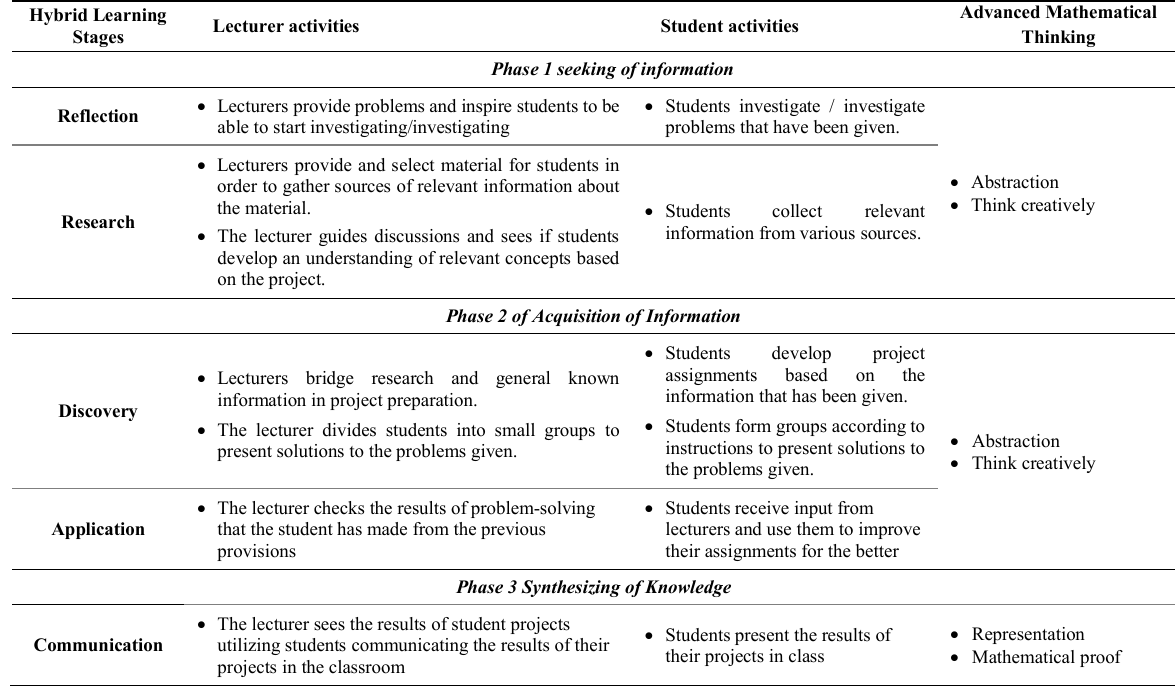
Table 2. Stages of Hybrid Learning.